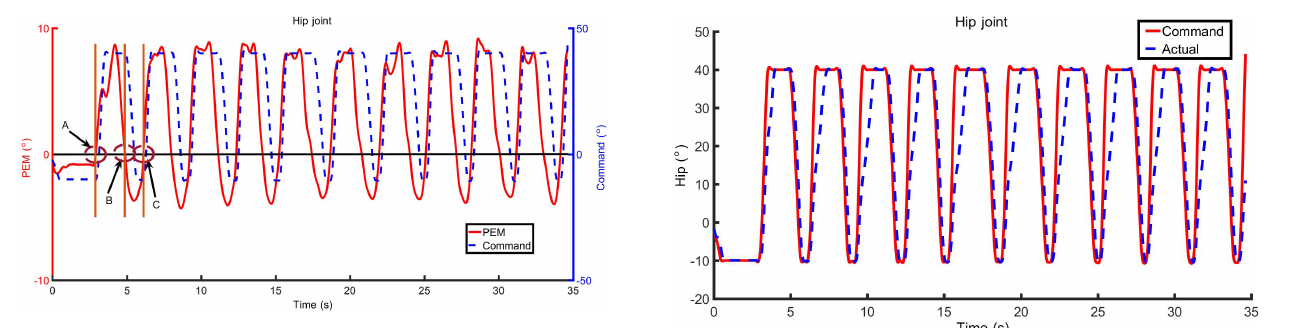
Figure 16. Trajectory tracking for the hip joint.